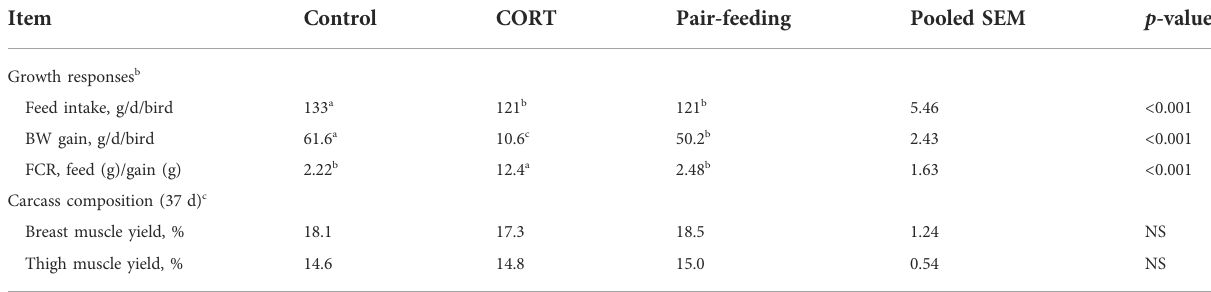
TABLE 2 Effects of corticosterone treatment (CORT, 30 mg/kg diet from 30 to 37 d of age) on growth performance and carcass characteristics of broiler chickens a .